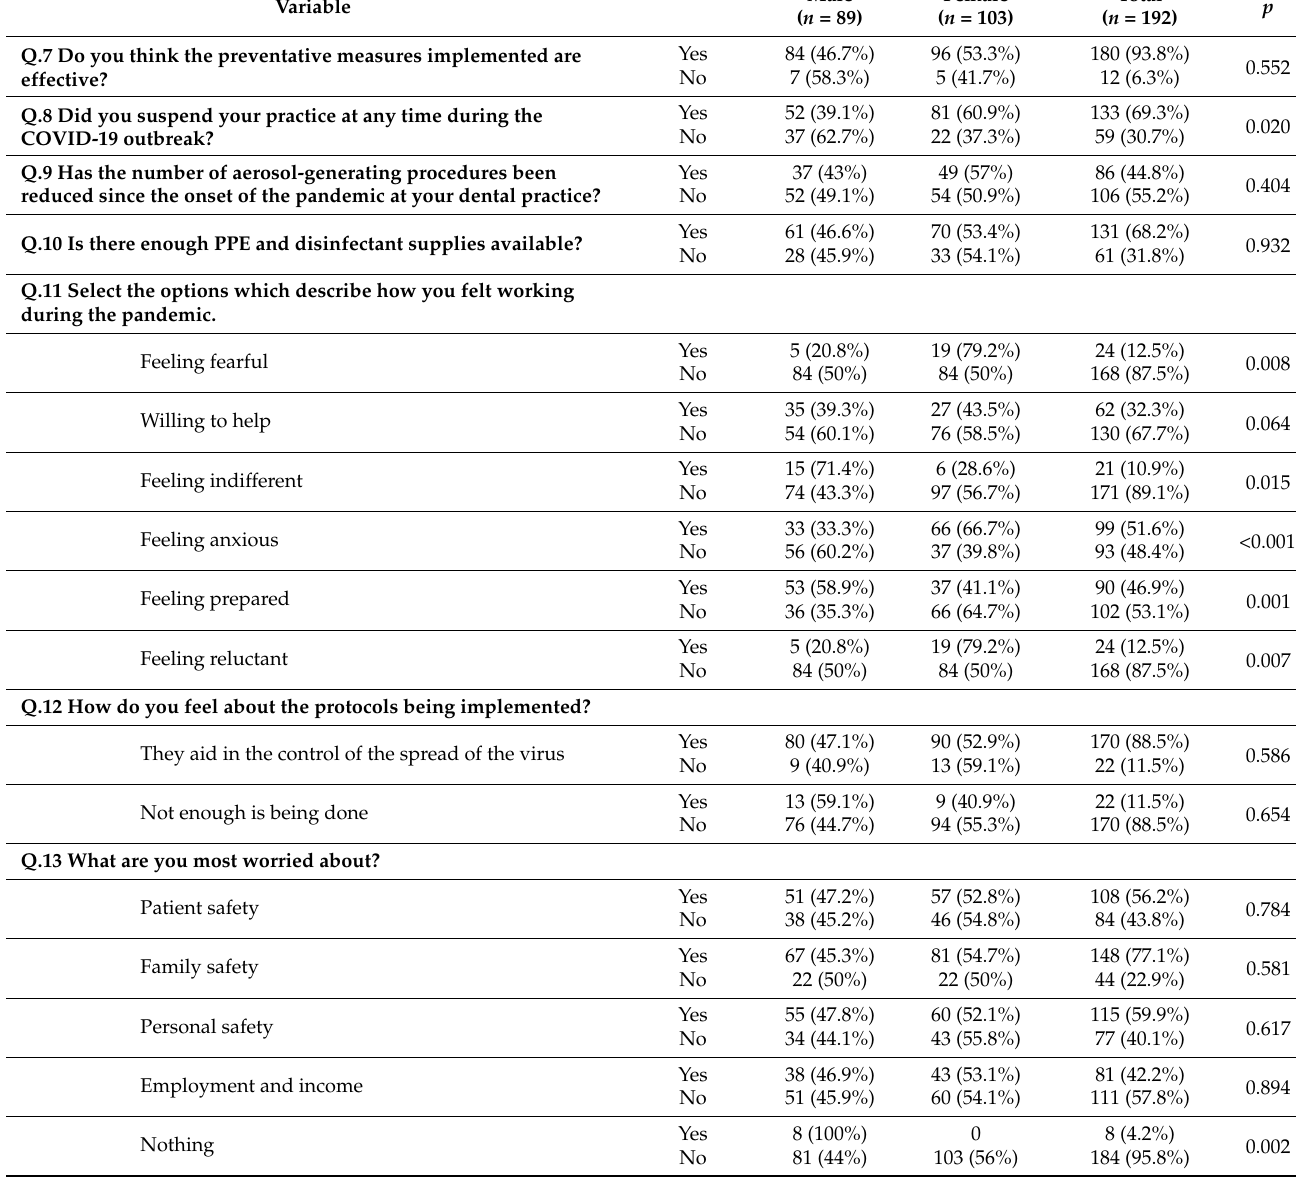
Table 3. Chi-square and Fisher exact test results for attitude towards COVID-19 by gender, p < 0.05.